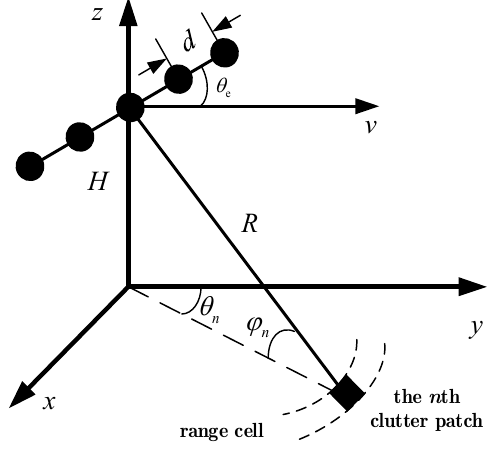
Figure 1. Geometry model of airborne